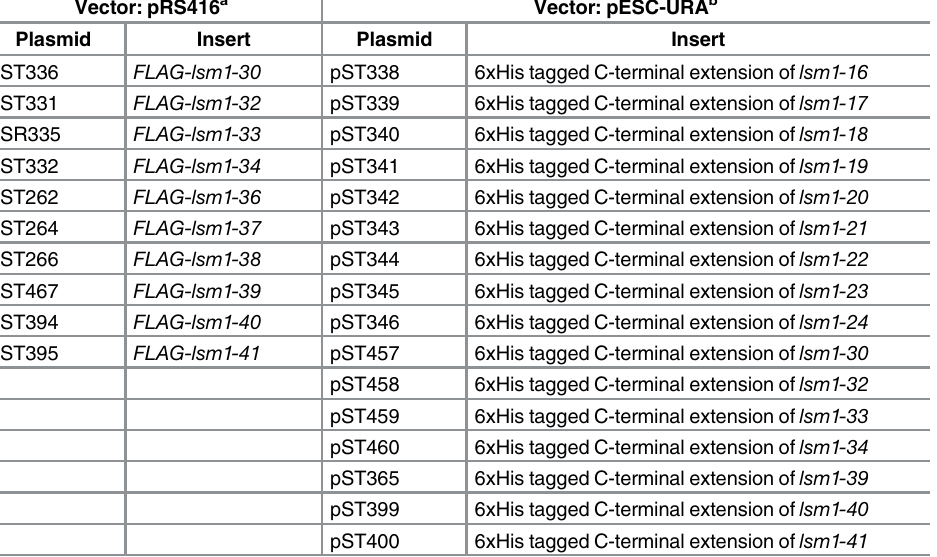
Table 1. Plasmids used this study. Vector: pRS416 a Vector: pESC-URA